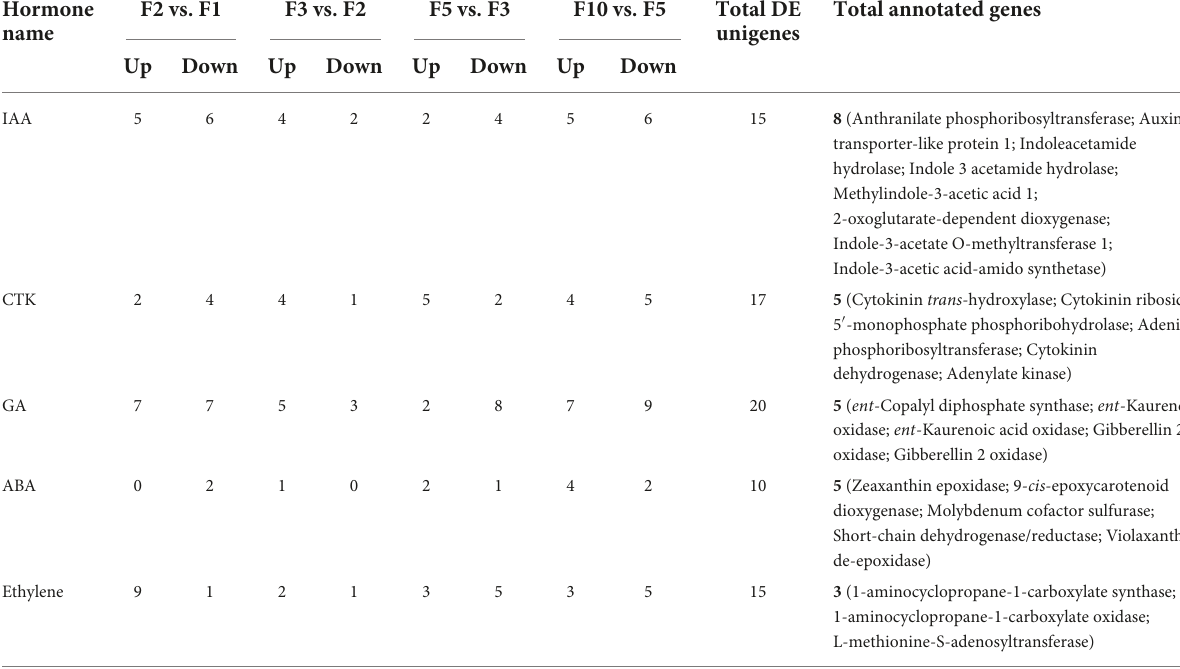
TABLE 1 Differentially expressed Dacrydium pectinatum unigenes involved in hormone biosynthetic and metabolic pathways among female cone samples. Hormone